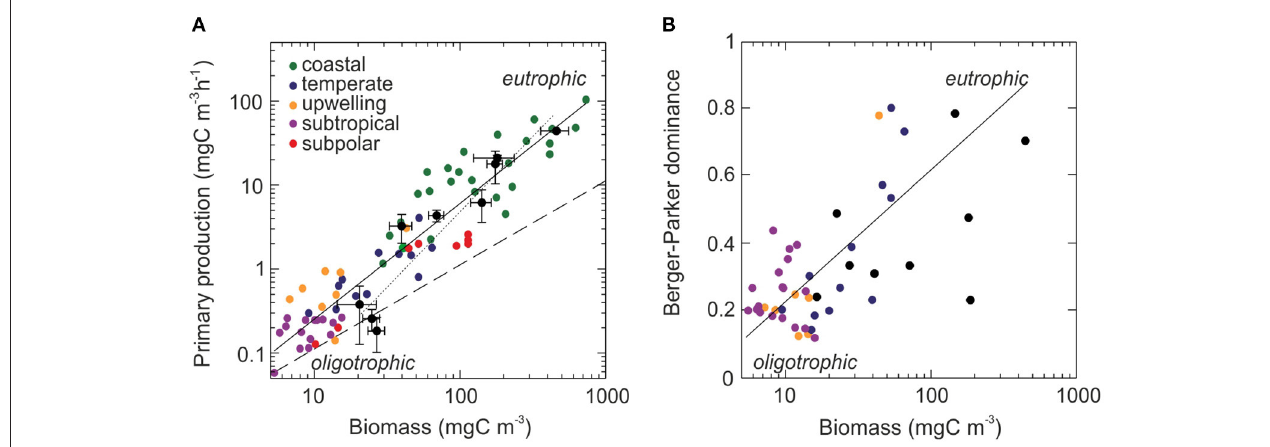
FIGURE 5 | (A) Relationship between primary production rate and phytoplankton C biomass across disparate regions of the ocean. Each data point represents the biomass and primary production rate of a phytoplankton community from data compilations (color dots) and this study (black dots). The error bars are the standard deviation. Lines represent the situation in which primary production rates increase proportional to biomass (dashed), the best fit to the entire dataset (solid) and the best fit to data from this study (dotted). (B) Changes in species’ dominance (Berger-Parker dominance index) plotted against community biomass. The pattern suggests that the strength of selection increases with increasing resource